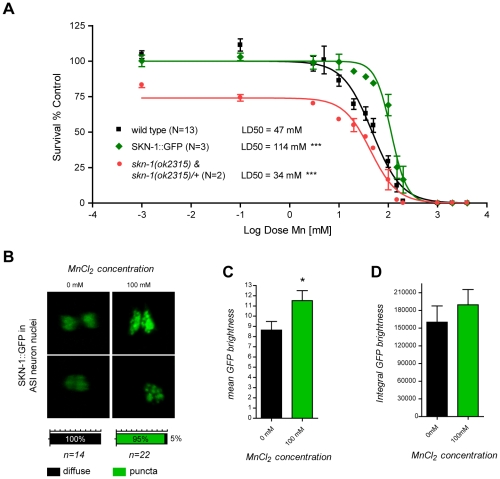
skn-1 mutants are hypersensitive while SKN-1::GFP overexpressing worms are hyper-resistant to Mn toxicity and respond to Mn exposure by relocalizing SKN-1::GFP to nuclear puncta in ASI neurons.(A) SKN-1::GFP expressing worms are hyper-resistant (p<0.001) to Mn-induced lethality, with a LD50 = 114 mM, while mixed skn-1(ok2315) and skn-1(ok2315)/+ are hypersensitive (p<0.001) to Mn exposure, with a LD50 = 34 mM. (B) SKN-1::GFP nuclear localization in ASI neurons reorganizes in puncta 1 hour after MnCl2 exposure. (C) SKN-1::GFP mean brightness significantly increases (p<0.05) in ASI nuclei upon Mn exposure while integral brightness does not (D).